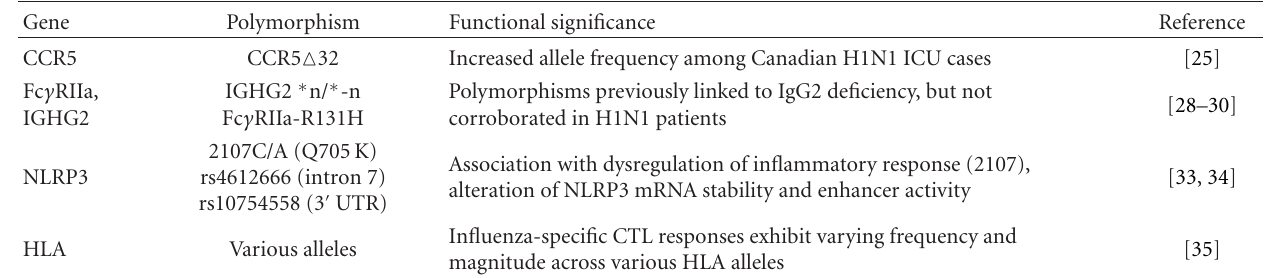
Table 1: Genetic polymorphisms of interest in H1N1 susceptibility and